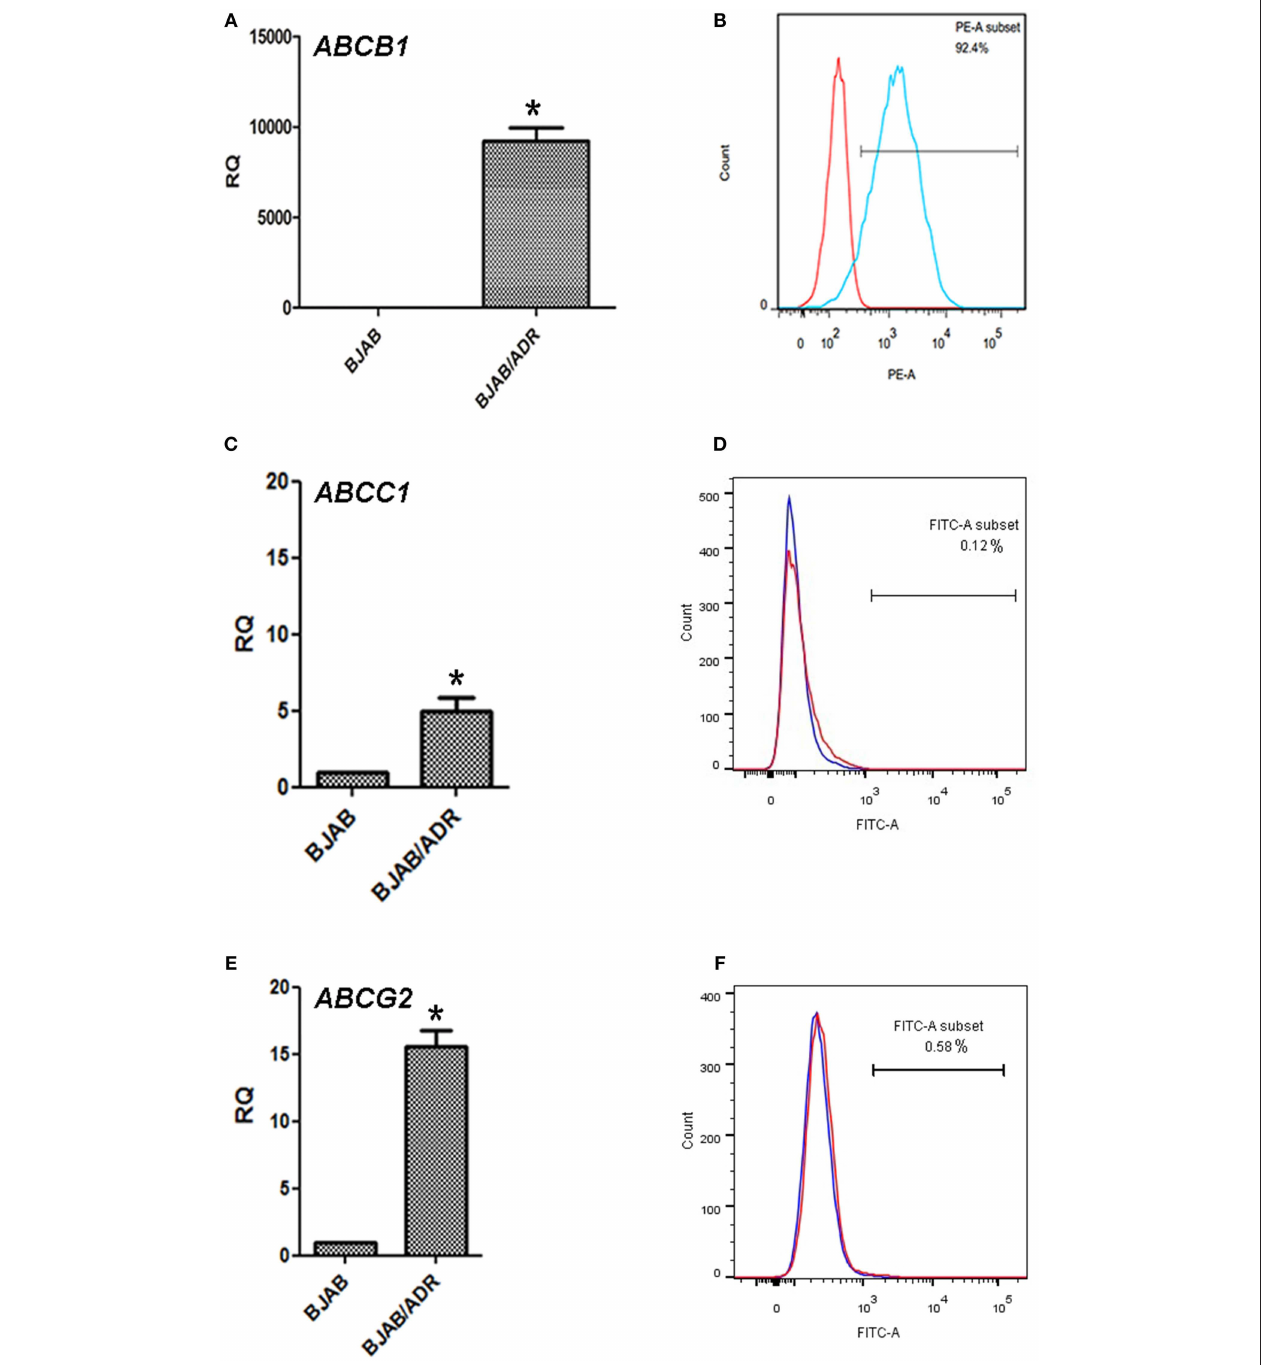
FIGURE 3 | Expression of the ABCB1 , ABCC1 , ABCG2 genes and P-gp, MRP1, BCRP proteins in BJAB/ADR cells. (A) The expression of the ABCB1 gene in the ADR-resistant BJAB/ADR cells. The mRNA level of MDR1 analyzed by qRT-PCR and normalized to the mRNA level of the housekeeping gene GAPDH. Compared with the sensitive cells BJAB, BJAB/ADR drug-resistant cells showed increased expression of ABCB1 mRNA. * P < 0.05, compared with control group. (B) The protein expression of P-gp on BJAB/ADR cells. The expression of P-gp was evaluated via flow cytometry analysis. BJAB/ADR cells showed higher expression of the membrane protein P-gp compared with the BJAB sensitive cells. (C,E) The qRT-PCR on the gene expression of ABCC1 and ABCG2 , respectively. These results showed higher expression levels of both genes, but the increased expression was not as high as that of ABCB1 . * P < 0.05, compared with control group. (D,F) The protein expression level of MRP1 and BCRP, separately. The results were obtained from flow cytometry analysis. These results indicated that higher expression levels of both protein, but the increased expression was not as high as that of P-gp.